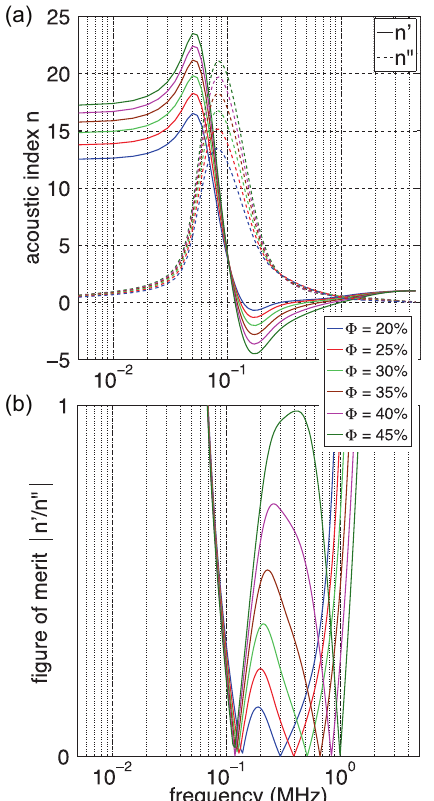
Figure 4. (a) The real and imaginary parts of the acoustic index n (= n 0 + i n 00 ) of an acoustic metafluid with different volume fractions U of soft porous silicone micro-beads with a mean radius of 160 l m and a size dispersion of 25%. (b) Corresponding figures of merit (FOM) are defined as the ratio | n 0 / n 00